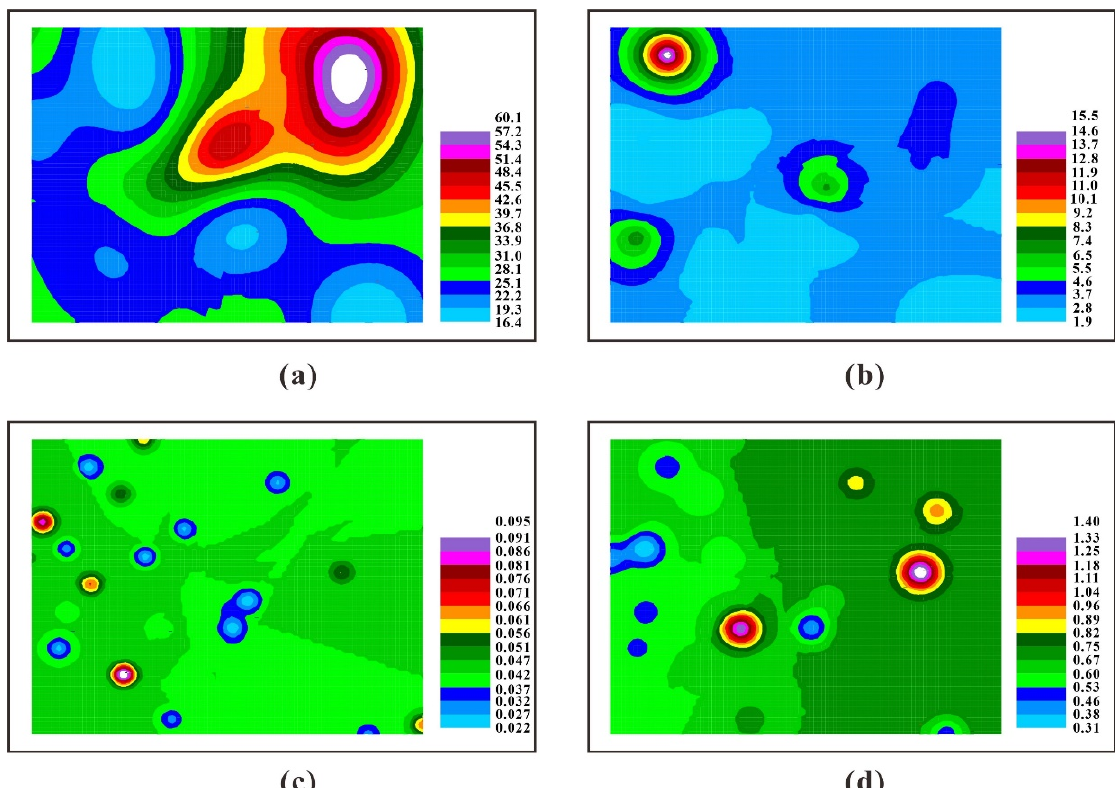
Figure 4. Interpolated maps of SOCD ( a ), TND ( b ), APD ( c ), and AKD ( d ) at 0–60 cm.